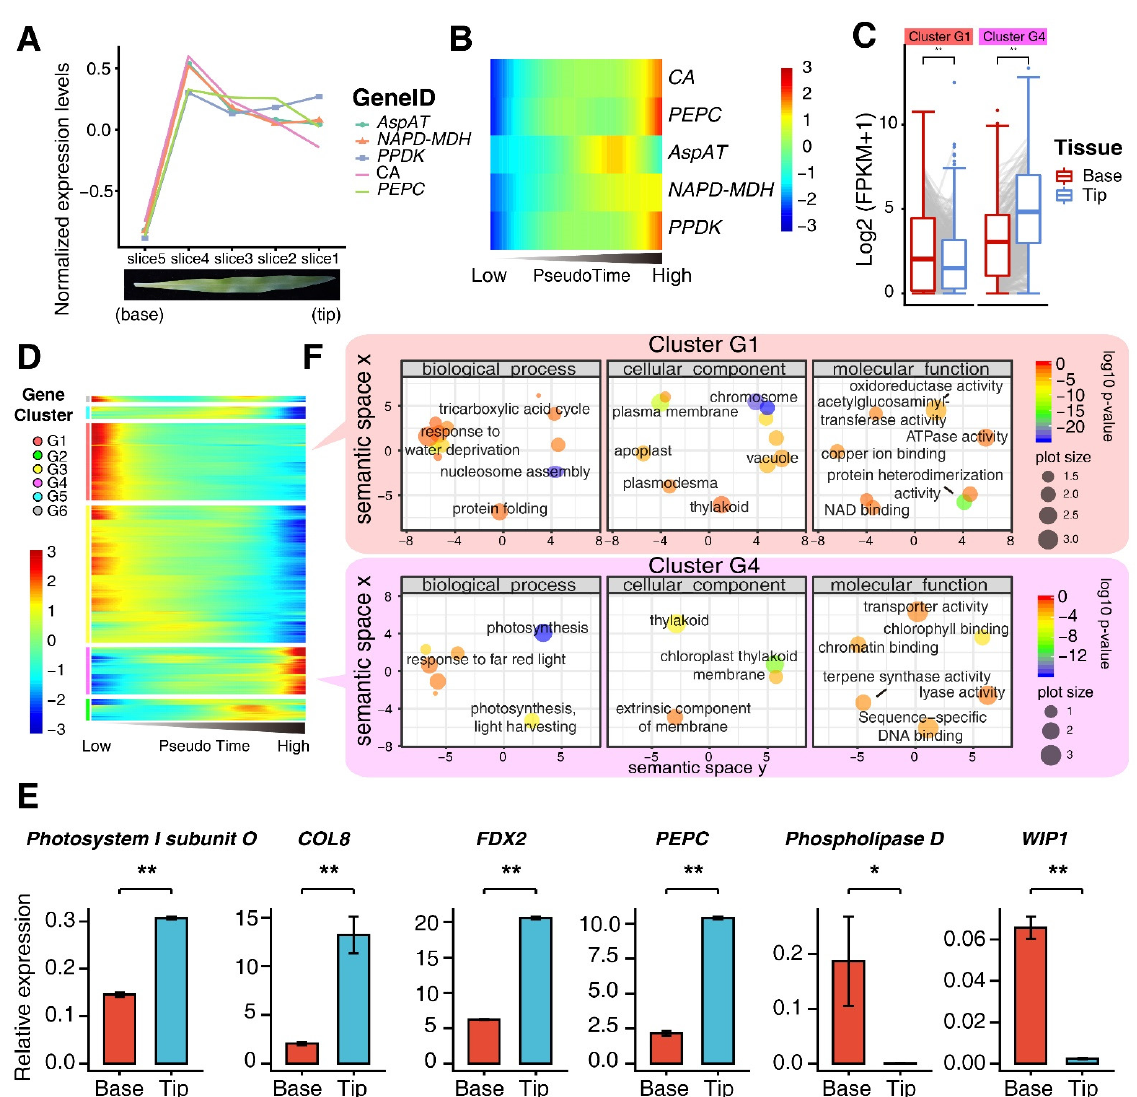
Figure 2. Dynamic expression profiles across pseudo time. ( A ) Expression profiles for AspAT , NAPD-MDH , PPDK , CA and PEPC genes in the bulk M-cell RNA-seq data generated from different dissected parts of the single leaf starting from the base to the tip as shown in the diagram (top) and the image form the real leaf (bottom). ( B ) Heatmap showing expression levels of AspAT , NAPD-MDH , PPDK , CA and PEPC across the pseudo-time. ( C ) Expression levels for genes in Cluster G1 and Cluster G4 in the base and the tip from the published data sets. Boxplot showing expression levels for genes in Cluster G1 and Cluster G4 in the base and the tip from the published data sets. Significance test was determined using two-tailed Wilcoxon method (** indicates p < 0.01). ( D ) Expression heatmap exhibiting 2584 highly dynamically expressed genes across the pseudo-time during M-cell development. ( E ) RT-qPCR assays using genes selected from Cluster G1 and G3 and G4, respectively, which were conducted using mRNA extracted from the leaf bases and the leaf tips, respectively. The relative expression levels were presented as mean ± SD from three technical replicates. Significance test was determined using one-sided t -test, * indicates p < 0.05, ** indicates p < 0.01. ( F ) Semantic similarity-based scatterplot showing the enriched GO terms for Cluster G1 and Cluster G4 genes. The color of each dot represents the log 10 ( p -value) for the significance of the GO-term enrichment; the size of each dot represents the frequency of the GO term in the underlying GOA database (more general terms exhibit larger